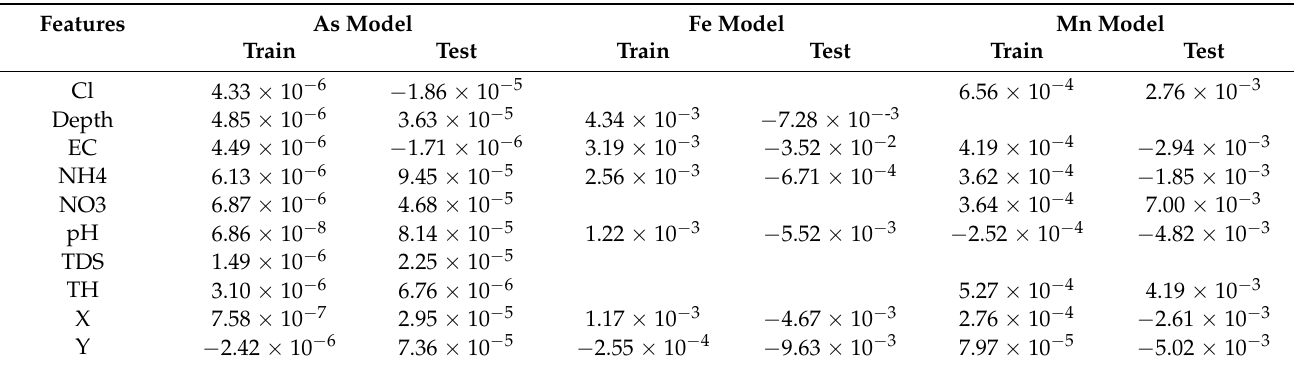
Table 7. Global feature contributions in each